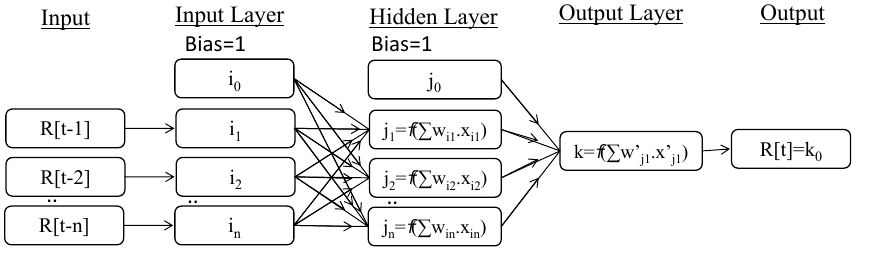
Fig. 1. MLP-NN model architecture.